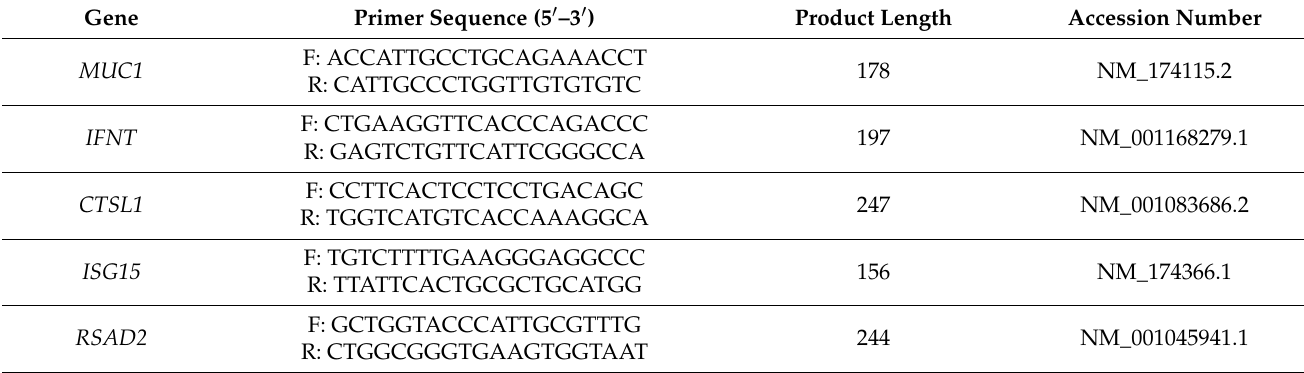
Table 1. Forward and reverse primer sequence for quantitative real-time polymerase chain reaction amplification of mRNA for bovine conceptus and endometrial samples.